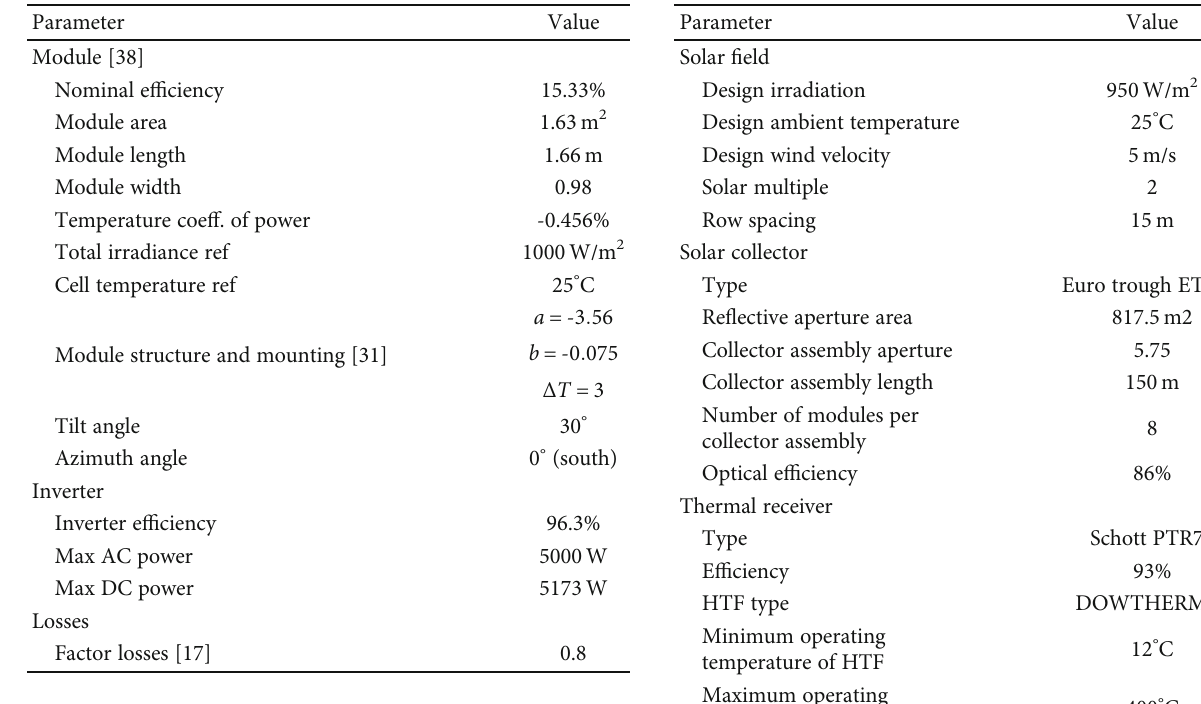
Table 2: Main parameters of the PV model. Table 3: Main parameters of the PV